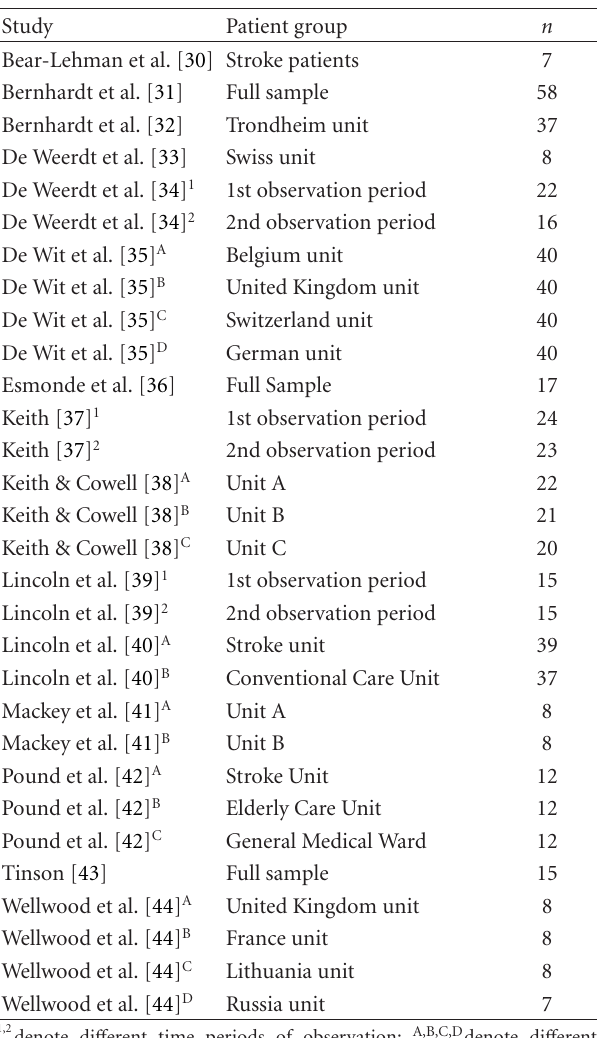
Table 2: Included studies showing number of included patients and reason for